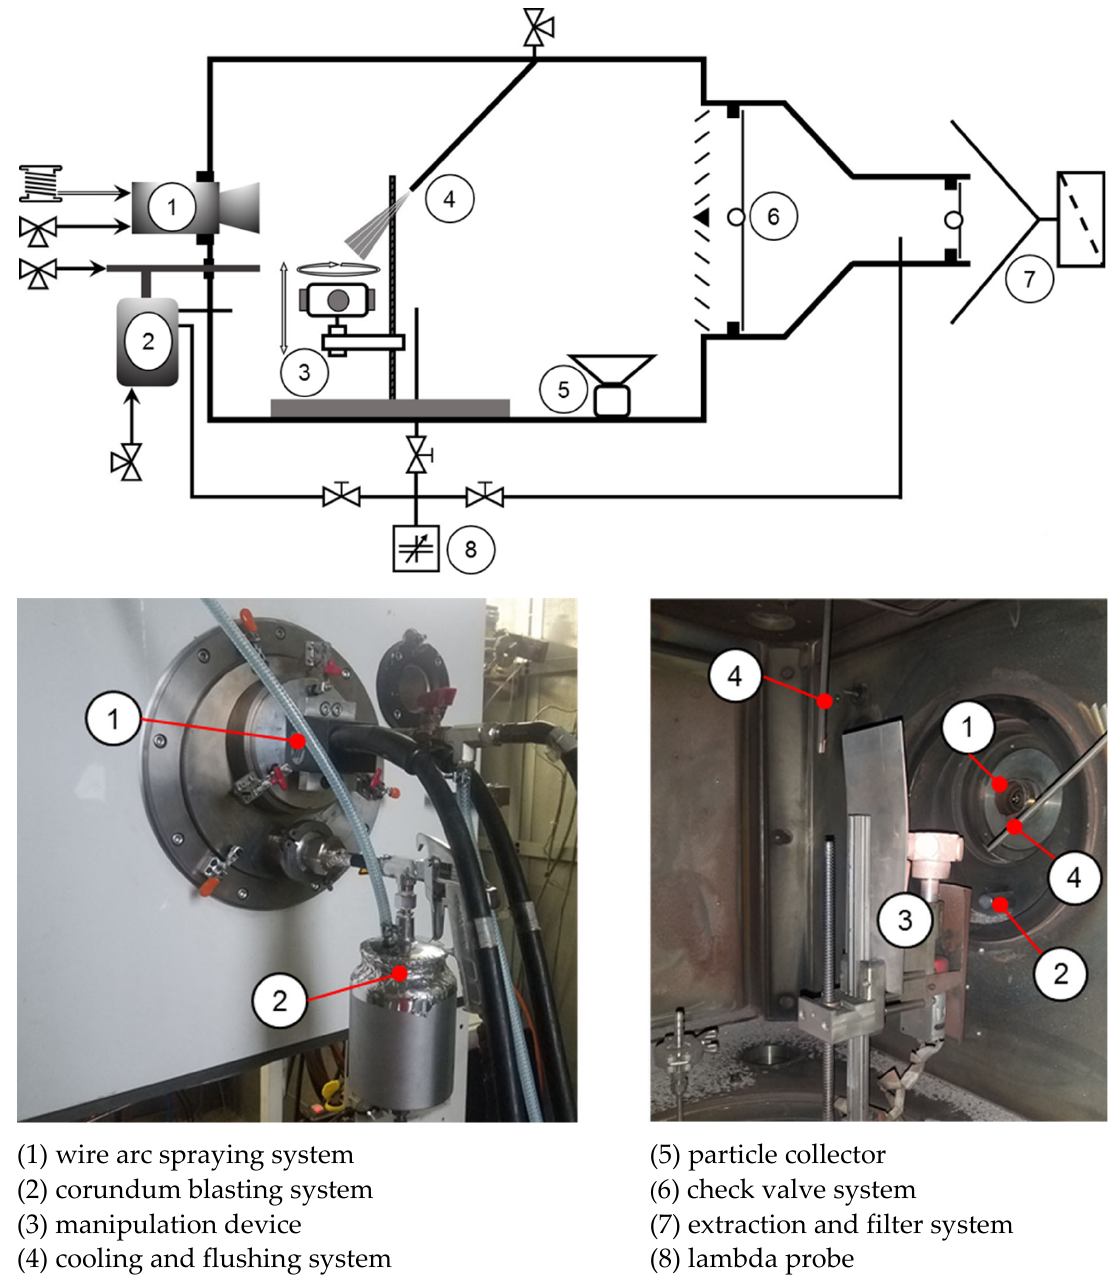
Figure 1. Schematic of the setup used for arc spraying in an oxygen ‐ free environment.